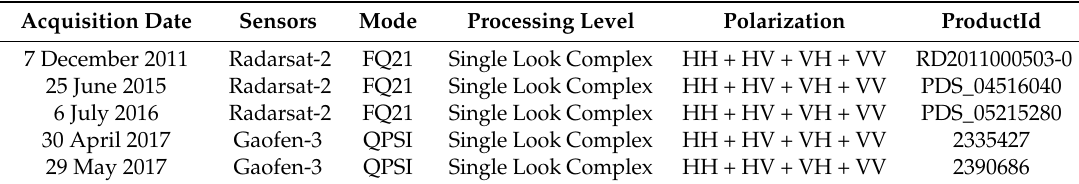
Table 2. The parameters of the Radarsat-2 and Gaofen-3 images.